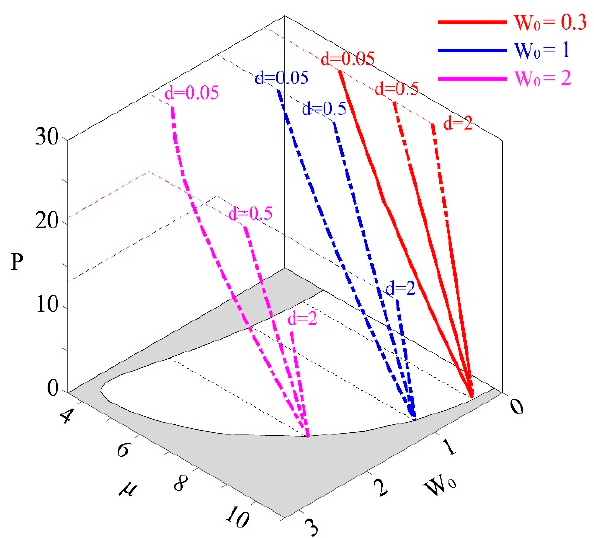
Figure 2. The power curves of dipole solitons in parity–time (PT)-symmetric triangular lattices with di ff erent nonlocality, d , and degree of gain / loss, W 0 . The gray area in the µ – W 0 plane (propagation constant µ versus degree of gain / loss W 0 ) is the optical energy band of the triangular lattices, thus the white area is the first bandgap. The solid lines indicate that the dipole solitons are stable, while the dashed lines indicate that they are unstable.